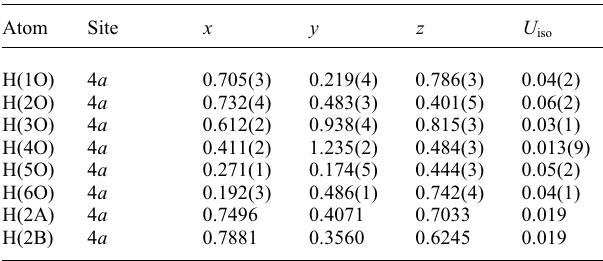
Table 2. Atomic coordinates and displacement parameters (in Å 2 )